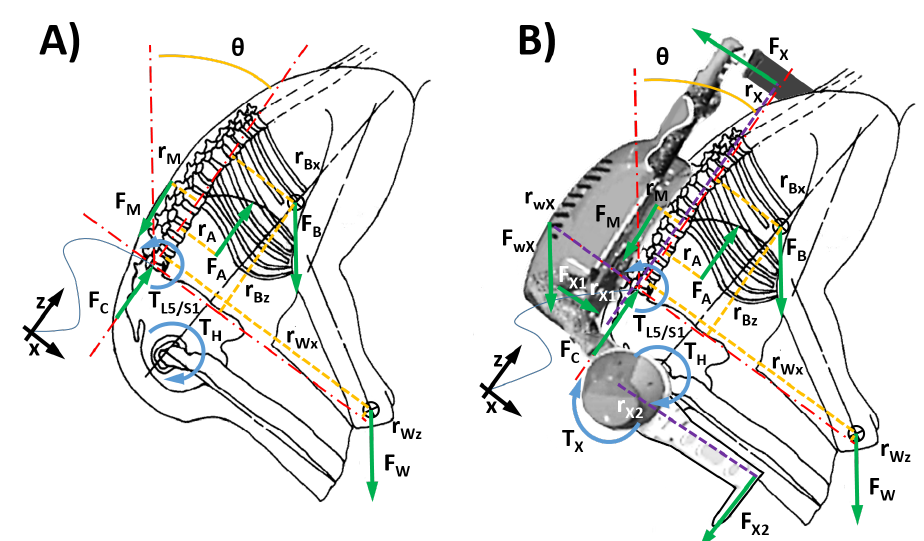
Figure 2. ( A ) Biomechanical model showing forces and moments operating on the L5/S1 joint during load lifting. ( B ) Biomechanical model showing forces and moments operating on the L5/S1 joint during load lifting when assisted by a back-support